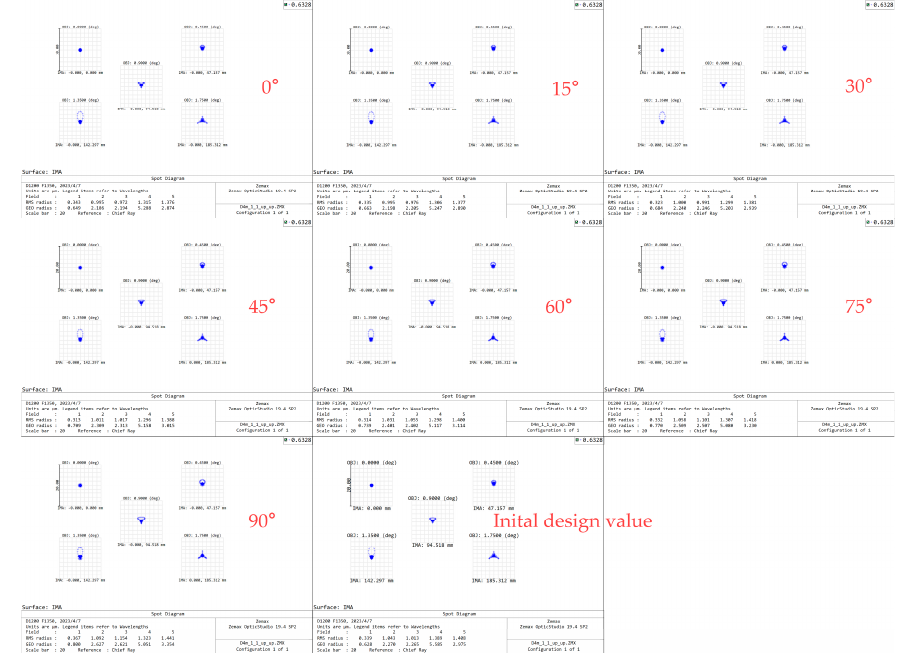
Figure 15. Imaging quality analysis (spot diagram).